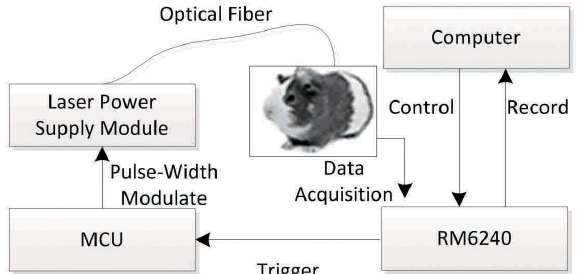
Fig. 1. Schematic diagram of the optical experiment. The pulse width was modulated by microcontroller unit (MCU). The output power was measured at the distal end of the ¯ber, ranging from 0 W to 2.3 W. A physiological signal acquisition system (RM6240C, Chengdu Instrument Factory, and Chengdu, China) was used to collect the signals and then transmitted to the computer.